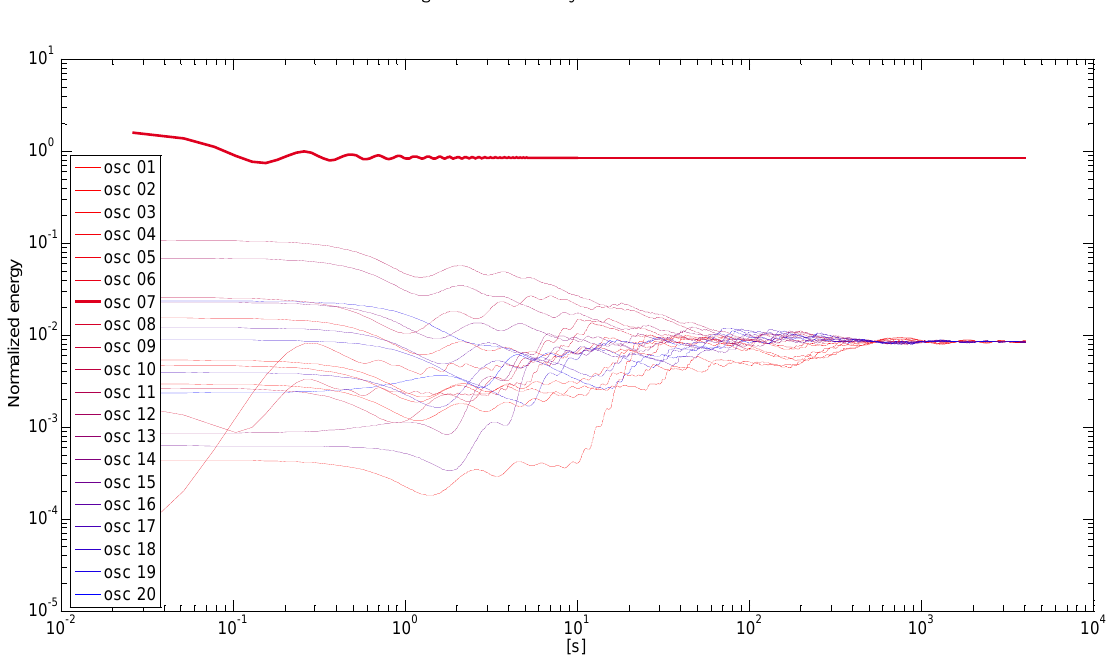
Fig. 7. Initial velocity vector versus mode index.